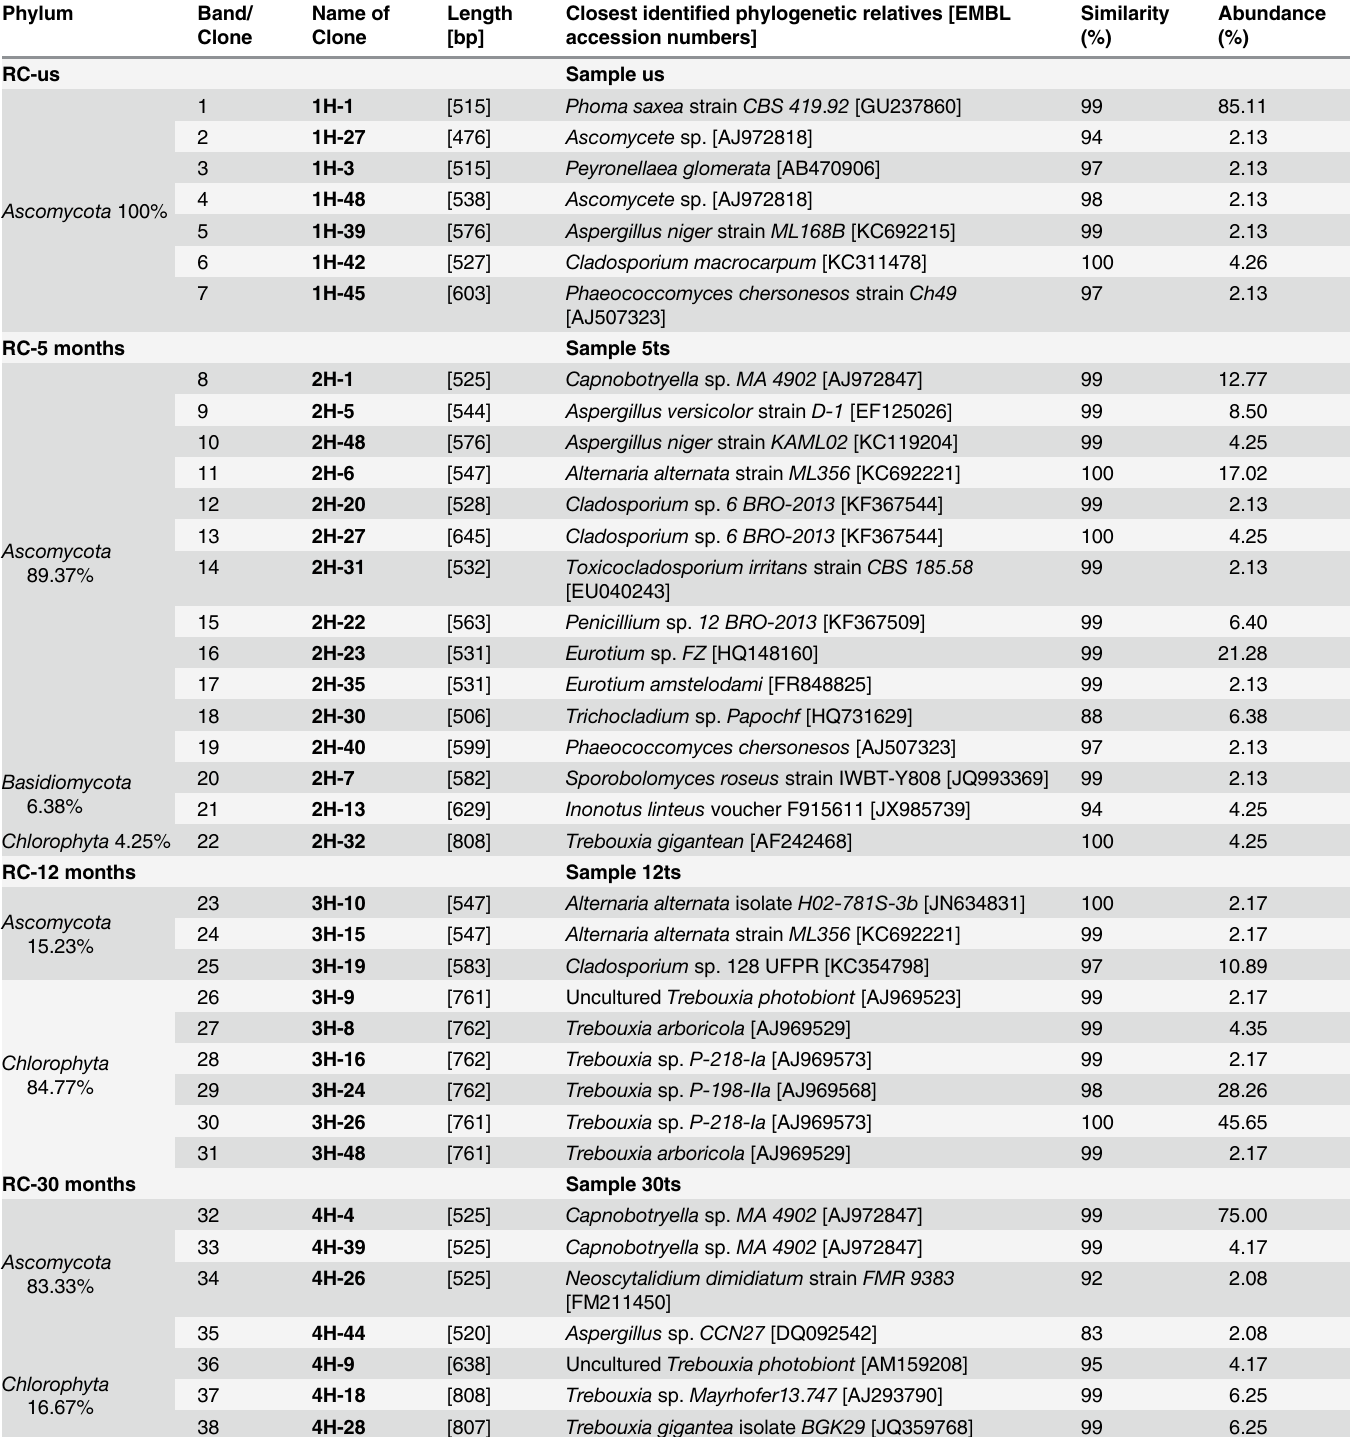
Table 2. Description of the different fungal clones obtained from untreated (us) and treated stones at five, twelve and thirty months after the appli- cation of the bio-consolidation treatment at the Royal Chapel (RC) in Granada. Clones numbers and calculated percentages show the sequenced clones amount related to the corresponding genus/species and